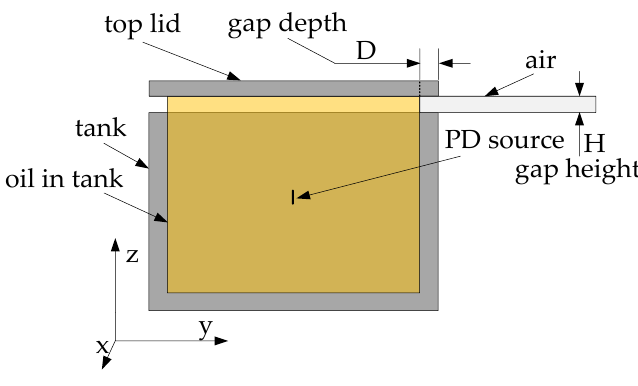
Figure 6. Simulation model.